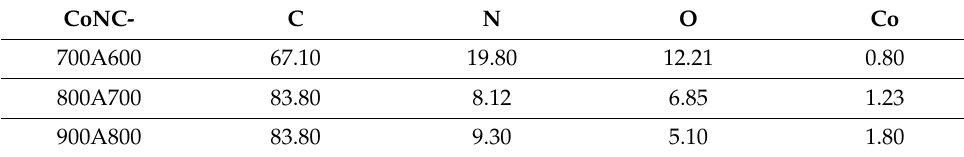
Table 2. Compositions of various Co–N–Cs obtained from EDs spectra.